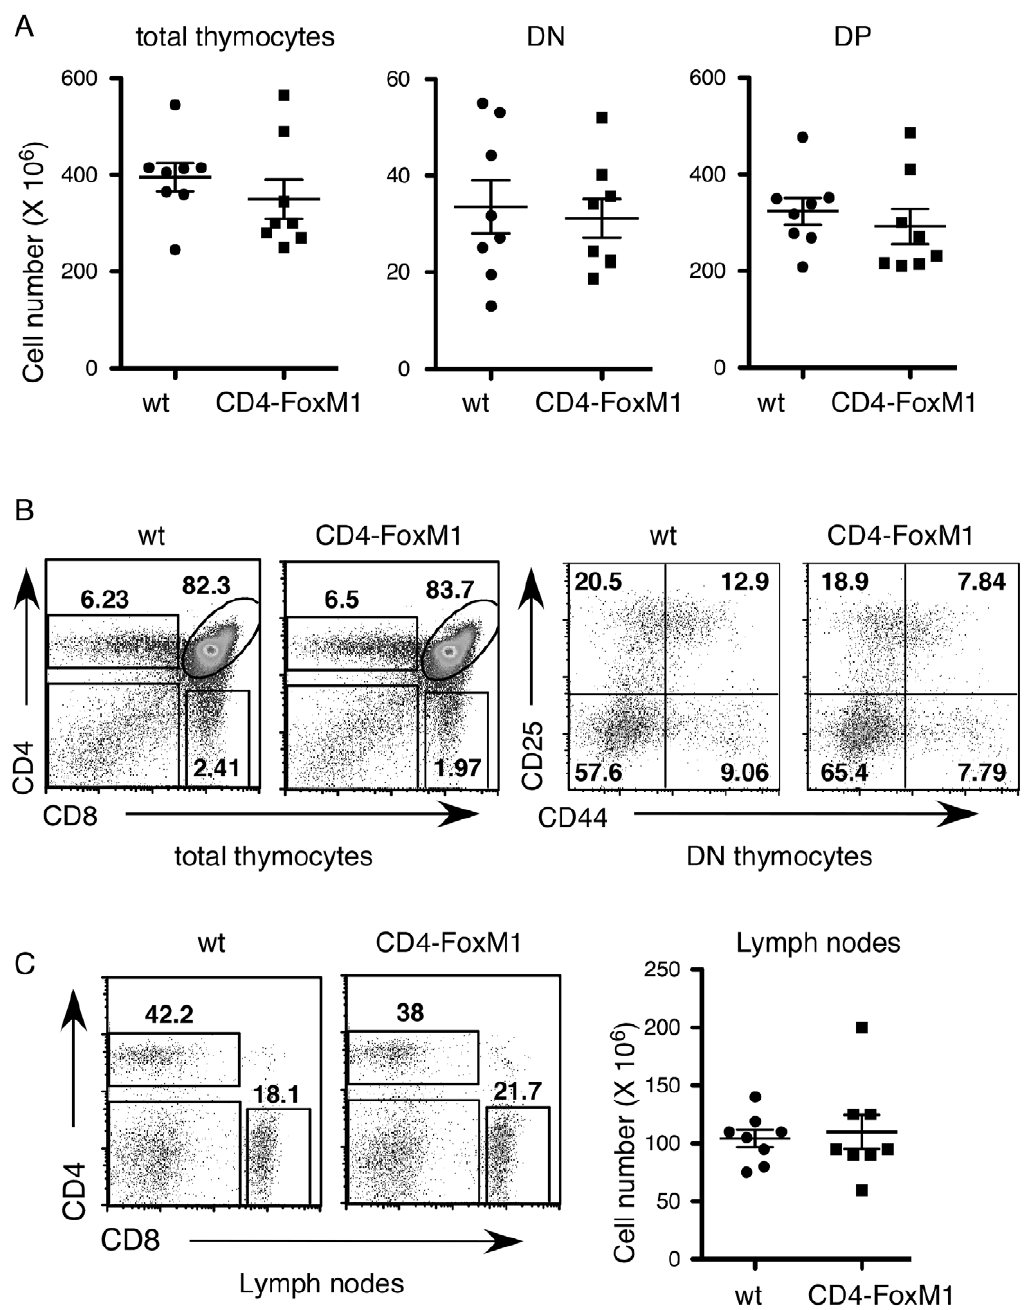
Figure 2. Characterization of CD4-FoxM1 mice. (A) The total number of thymocytes, double negative (DN), and double positive (DP) from each mouse are depicted as a box or a circle ( n =8). (B) Representative plots of CD4 versus CD8 profiles of total thymocytes and CD44 versus CD25 profiles of gated DN thymocytes are shown. (C) CD4 versus CD8 profiles and the total number of cells in lymph nodes are shown here. Right panel: Each box or circle represents one mouse ( n